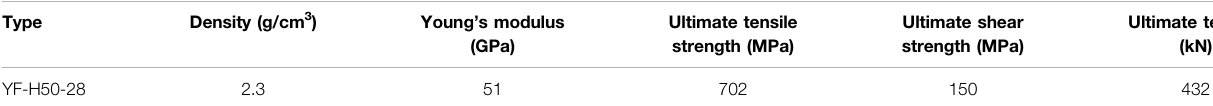
TABLE 1 | Mechanical parameters of the GFRP anchor.